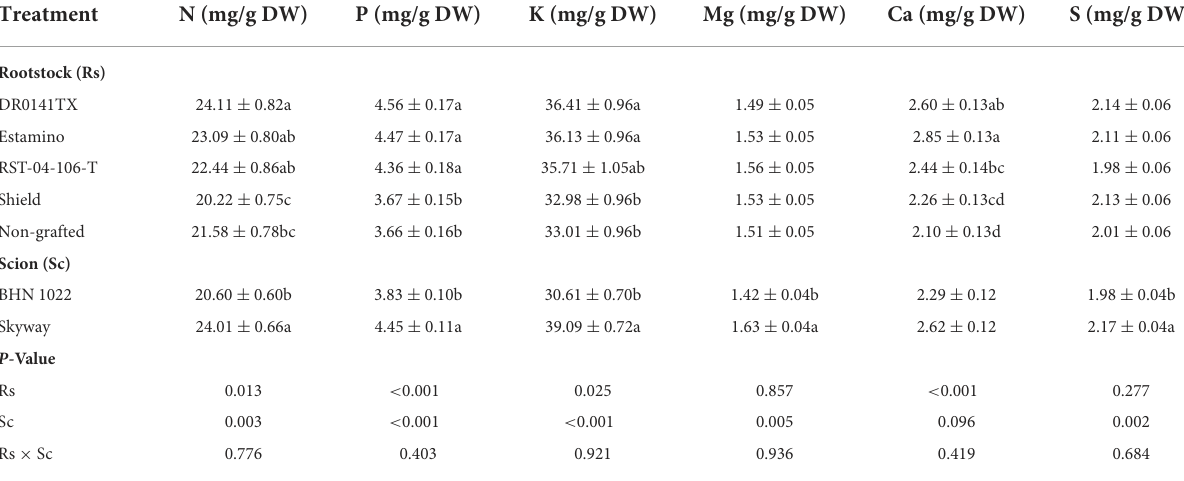
TABLE 8 Fruit macronutrient content on a dry weight basis in grafted tomatoes as affected by rootstock and scion cultivars in the fall planting (24 September 2020 to 15 April 2021). Treatment